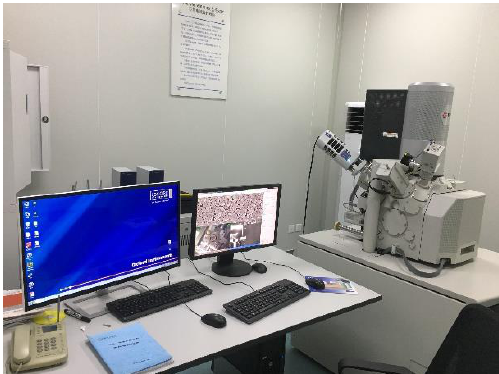
Figure 4. Nova NanoSEM450 scanning electron microscope.